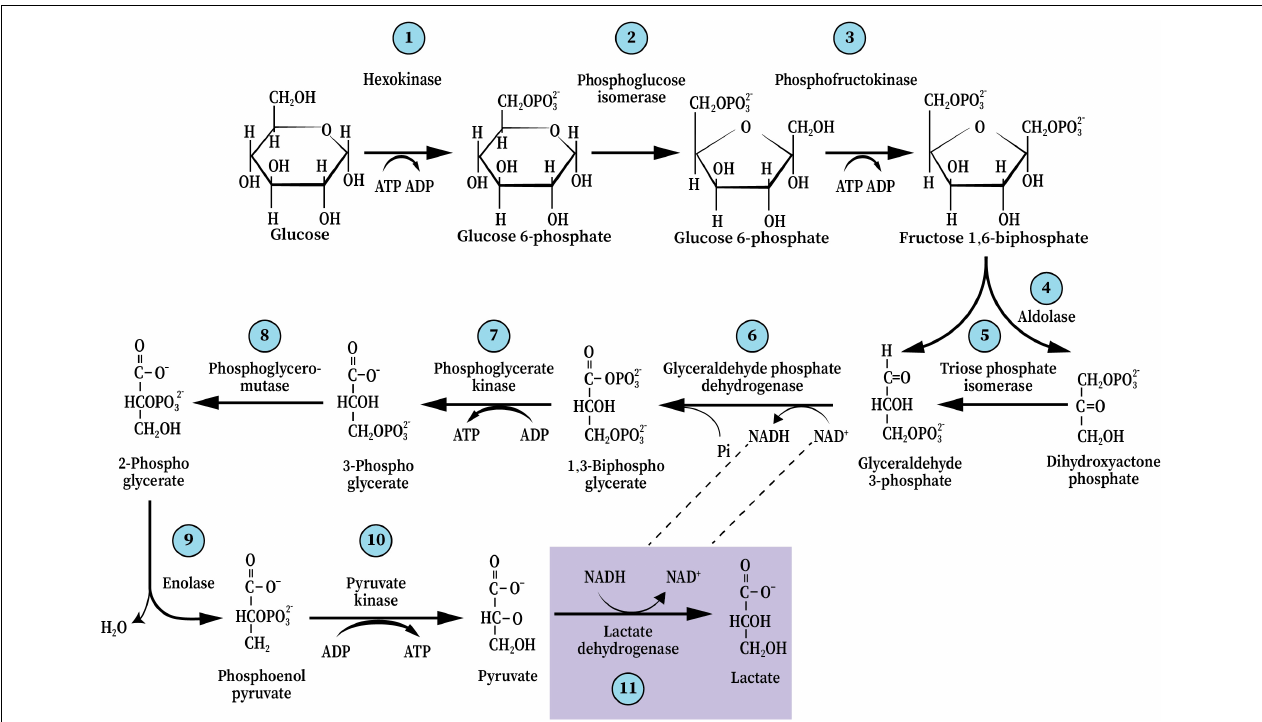
FIGURE 1 | The glycolytic pathway and the 10 enzymatic steps that break down one molecule of glucose into two trios molecules, ending with pyruvate (aerobically) or, with an 11th step, lactate (anaerobically). This dogmatic configuration has guided scientists and science students ever since it was elucidated in 1940.